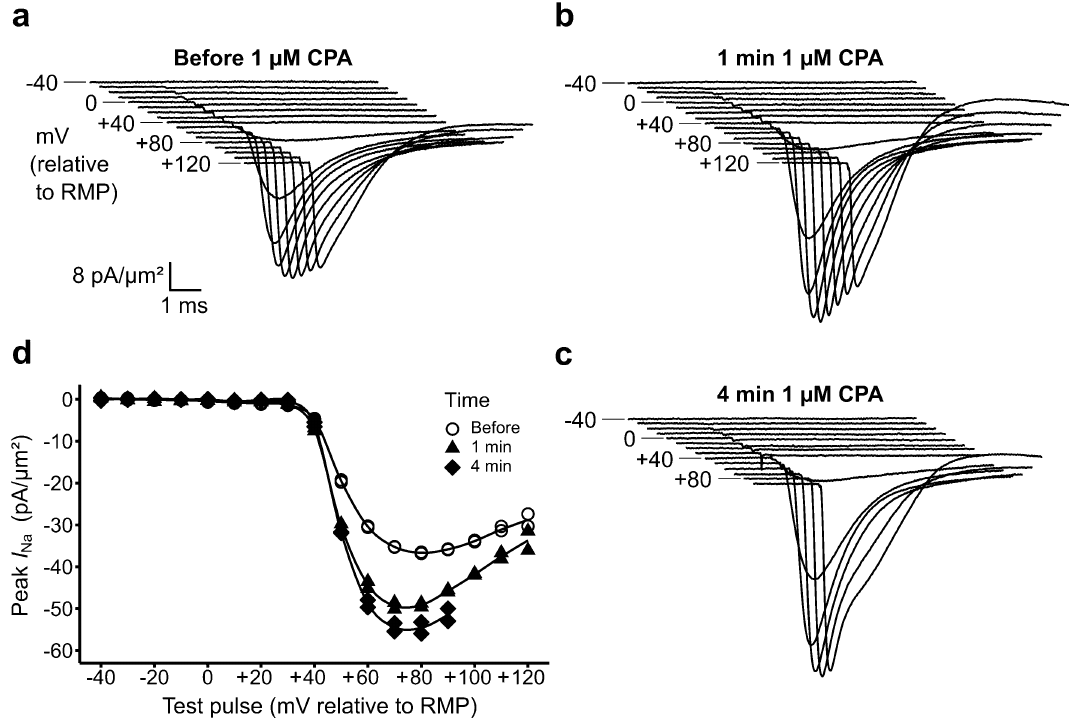
Figure 4. Effects of 1 µM CPA on currents and related I–V relationships. ( a – c ) Sets of current traces obtained from a patch ( a ) before, ( b ) 1 min and ( c ) 4 min after solution change to K–H solution containing 1 µM CPA. ( d ) Peak currents plotted against voltage excursion to give I–V relationships here illustrating a ~ 38% alteration in maximum peak current following the solution